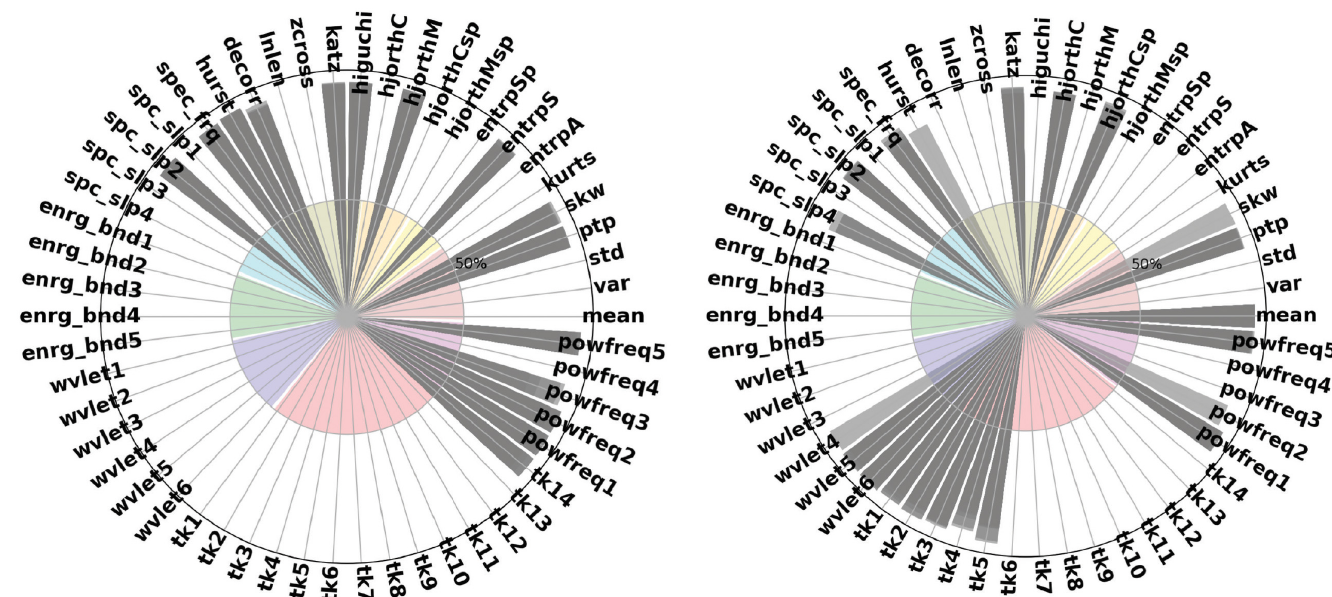
Fig 4. The effect of epoch (window) size on feature selection. We compare window sizes of w = 10s (left) and 2s (right).